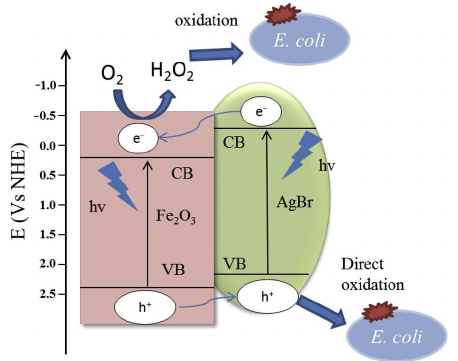
Figure 7. Schematic illustration of proposed mechanism of bacterial inactivation by Fe 2 O 3 -AgBr [101] . Copyright, 2016 Elsevier Inc.